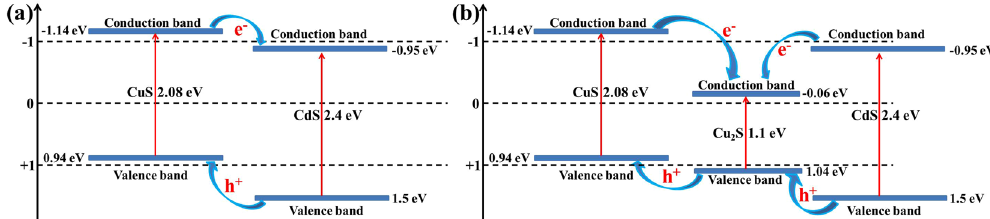
Figure 11. Schematic illustration of the band energy level and charge transfers for ( a ) CuS-CdS and ( b ) CuS-